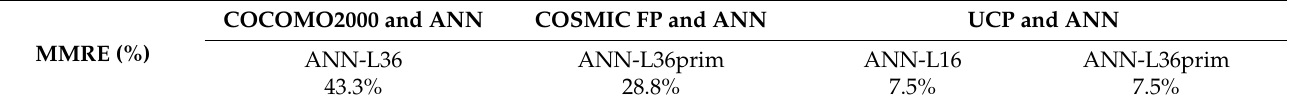
Table 13. COCOMO2000 and ANN vs. COSMIC FP and ANN vs. UCP and ANN.